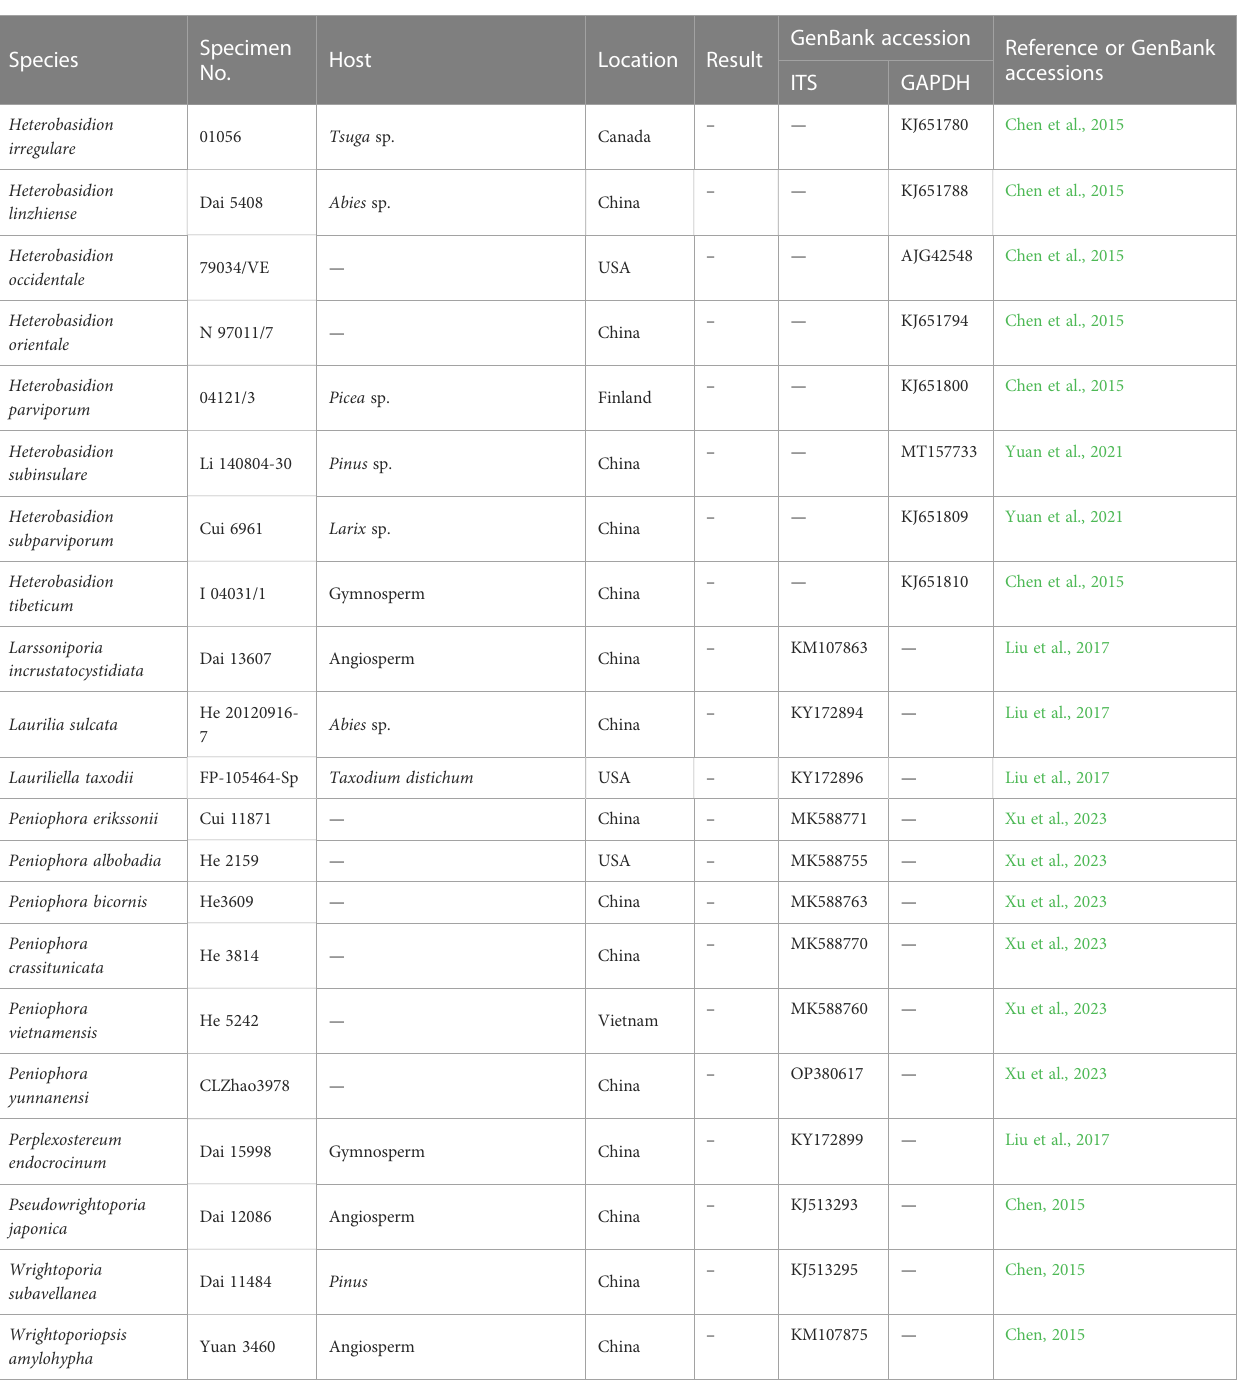
(Figure S2). Runs were performed with positive controls ( H. annosum ), negative controls (14 Heterobasidion spp. and 24 other fungi), and controls consisting of distilled water without DNA. The assays were evaluated by observation of the HNB color change from violet to blue, which denotes positive ampli fi cation, while a negative assay remains violet.Theoptimumtemperatureandshortestviabletimewereidenti fi ed as 63°C for 60 min. Each condition was repeated at least three